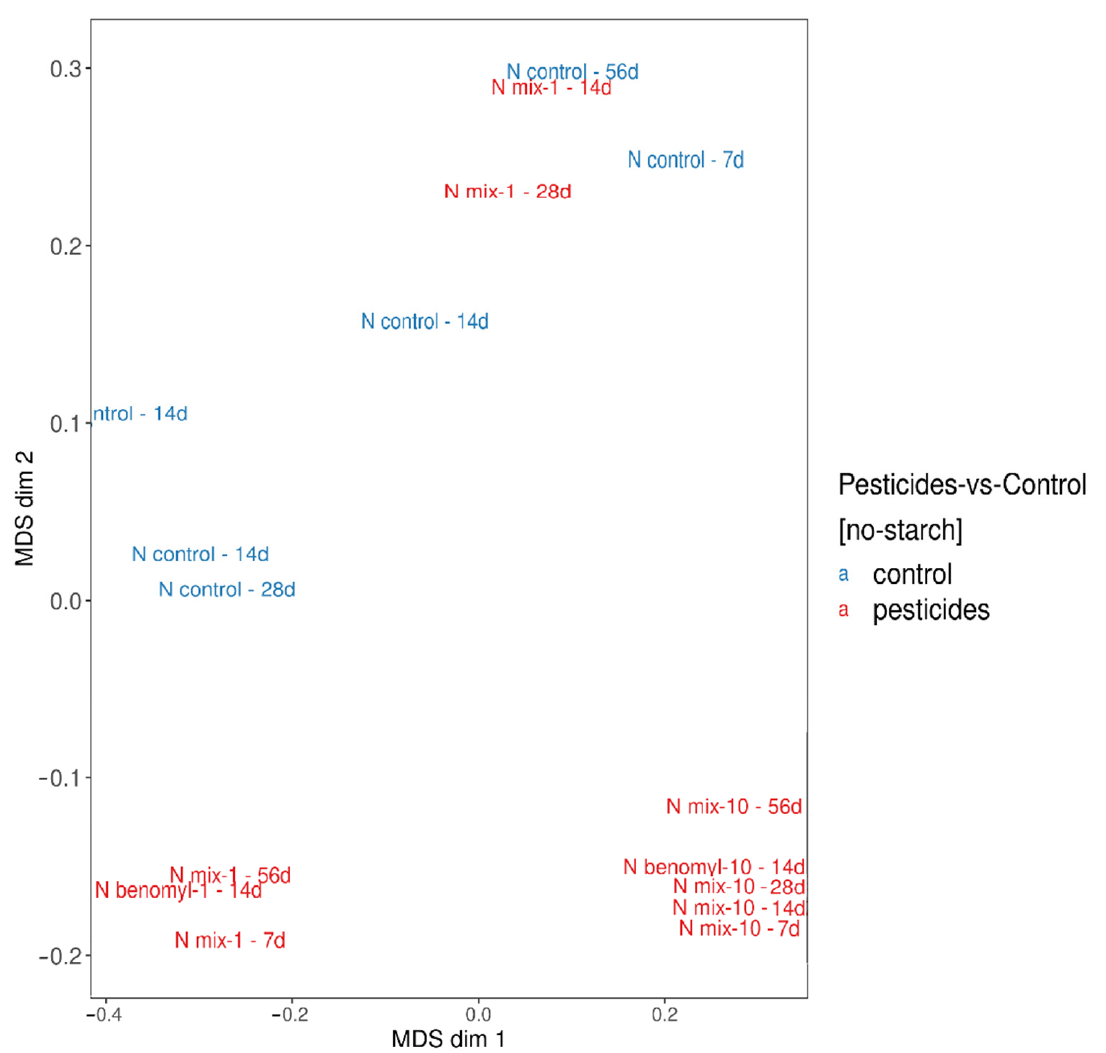
Figure 5. MDS plot representing the beta diversity of fungal community compositions (at genus level) in soil samples (without SMM) treated with pesticides (red) and control ones (blue). Samples treated with 10× application rate concentration form a separate cluster, distant from the other sam- ples.